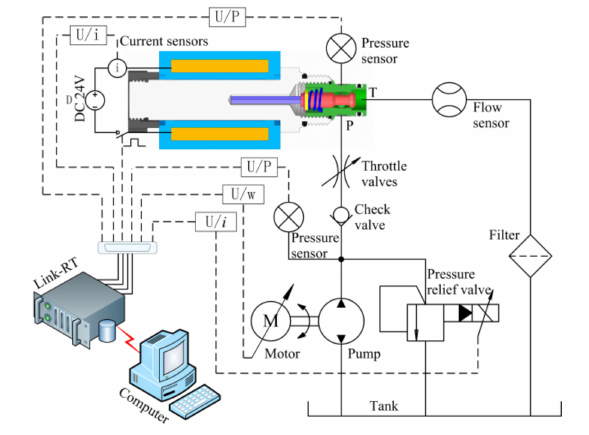
Figure 7. Schematic of the SCV measurement